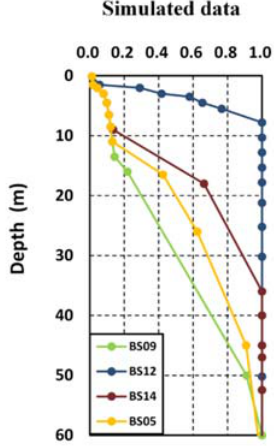
Figure 9. Changes of the liquid saturation with depth for four boreholes at the end of 2014.